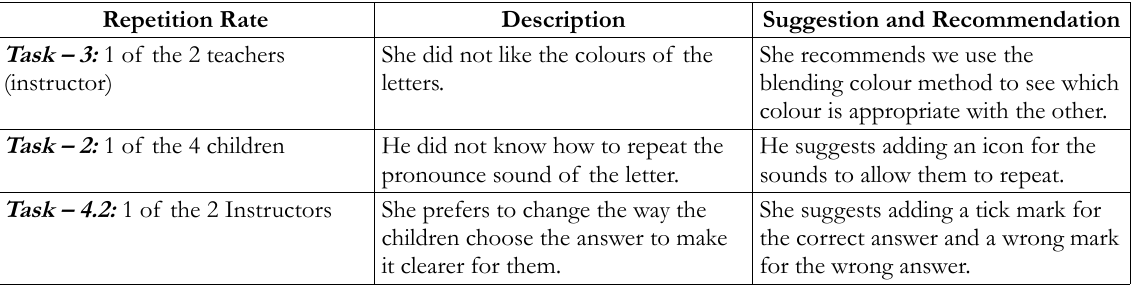
Table 5. Problems and recommendations